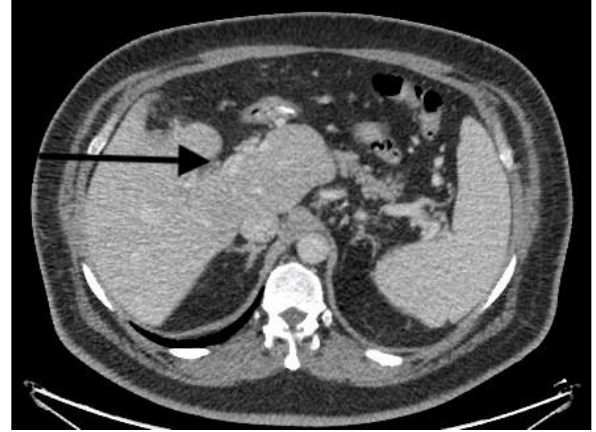
Figure 3. Recanalization of portal vein after 3-month CT.